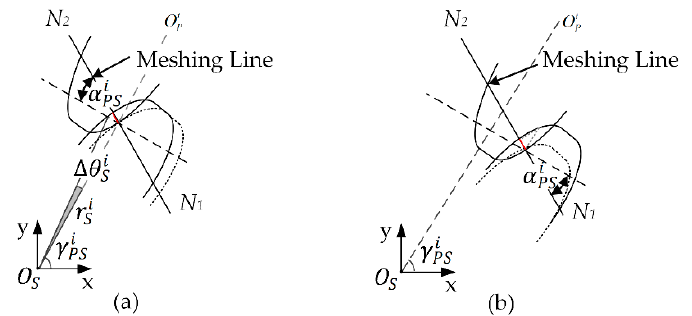
Figure 3. Composite deformation between the sun and i th planet gear: ( a ) deformation from angle difference: δ i , ( b ) deformation from center distance variation: δ i θ n − PS